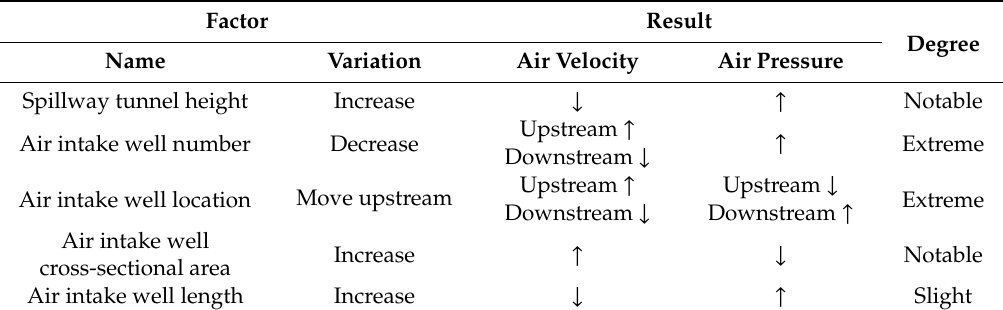
Table 2. The influences of the structural factors on the ventilation characteristics.